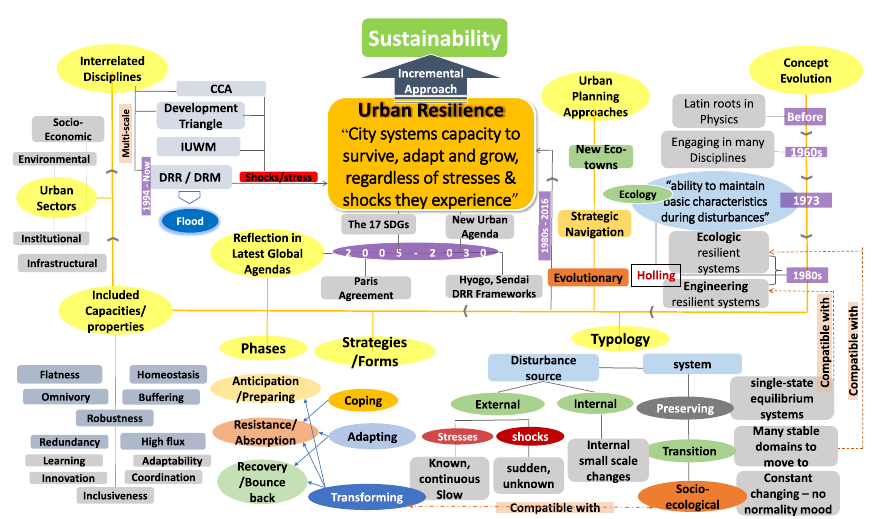
Fig. 6 Conceptualizing urban resilience